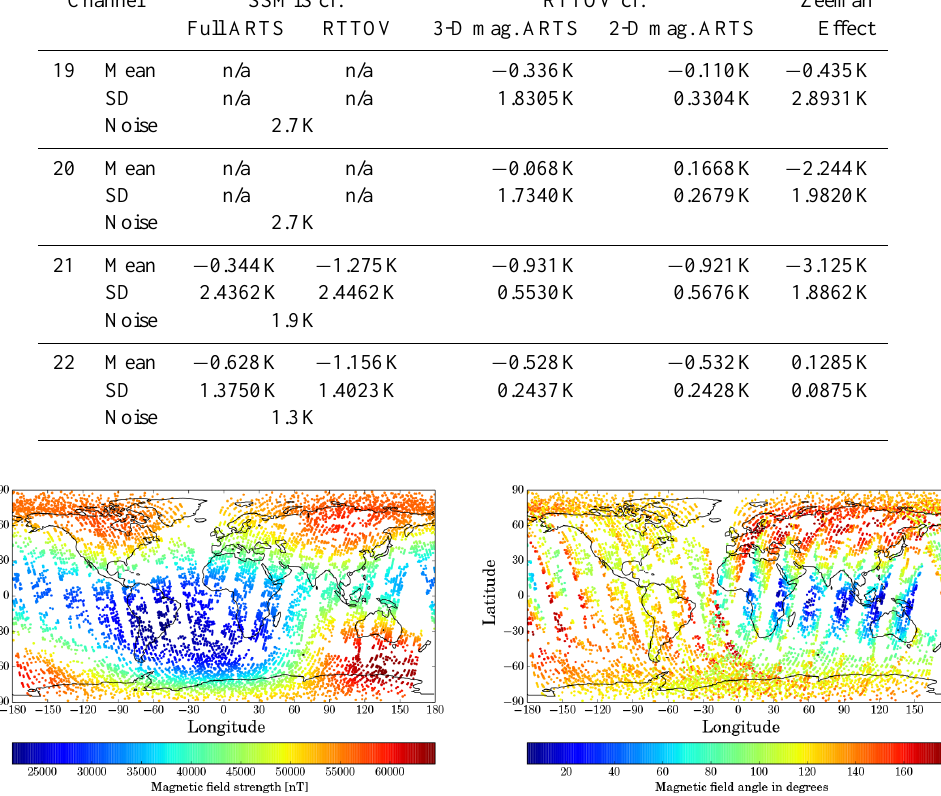
Figure 2. Magnetic field used in our simulation mapped on a two-dimensional surface showing the strength of the field in the left panel. The right panel contains the angle between the magnetic field vector and the radiation’s propagation path. (This figure appears in Larsson (2014) and is republished with rights from